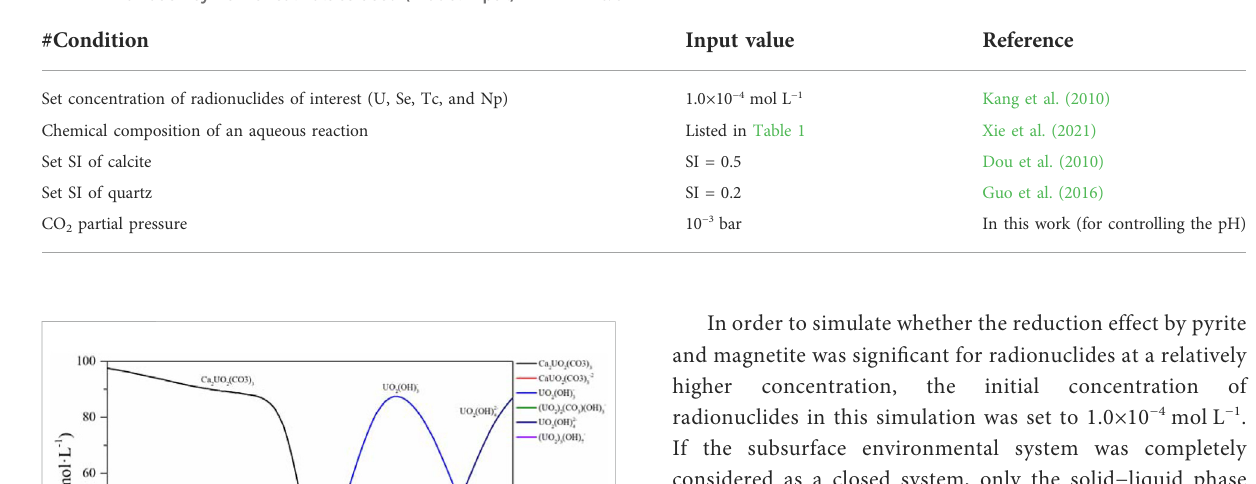
TABLE 2 Various key numerical values used (model input) in PHREEQC.